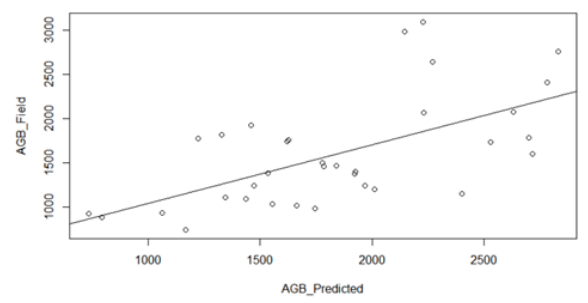
Figure 5. Relation between Observed and Predicted